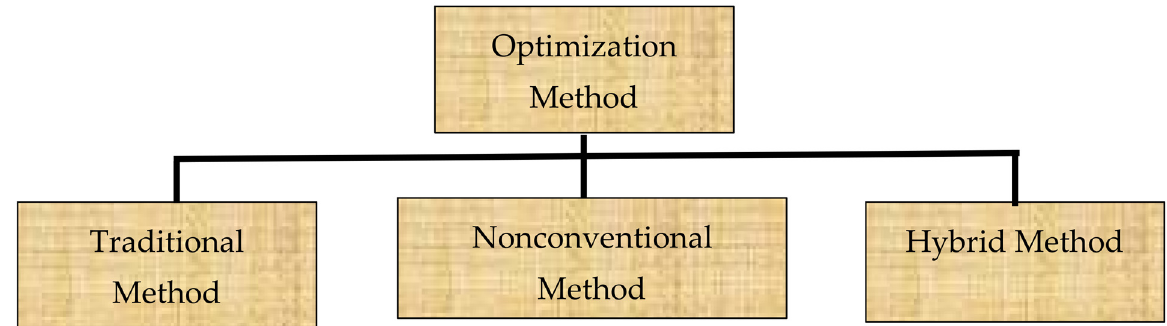
Figure 1. Classification of optimization methods.